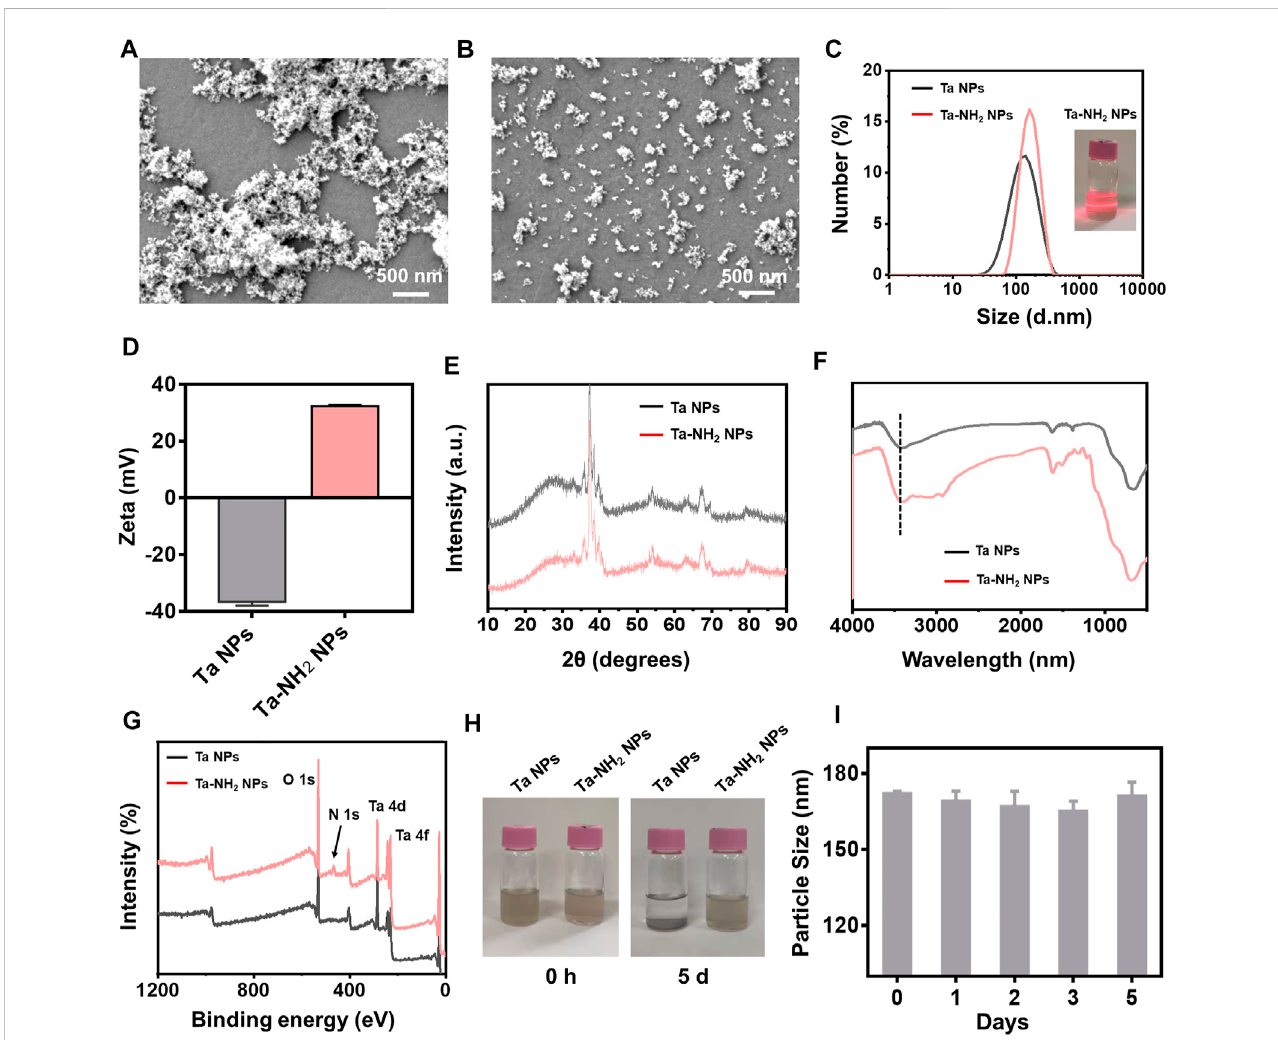
FIGURE 2 Morphological and compositional characterizations of Ta-NH 2 NPs. (A) SEM image of Ta NPs and (B) SEM image of Ta-NH 2 NPs. (C) Hydrodynamic diameters and (D) Zeta potential of Ta NPs and Ta-NH 2 NPs measured by DLS. (E) XRD patterns and (F) FT-IR spectra of Ta NPs and Ta-NH 2 NPs. (G)